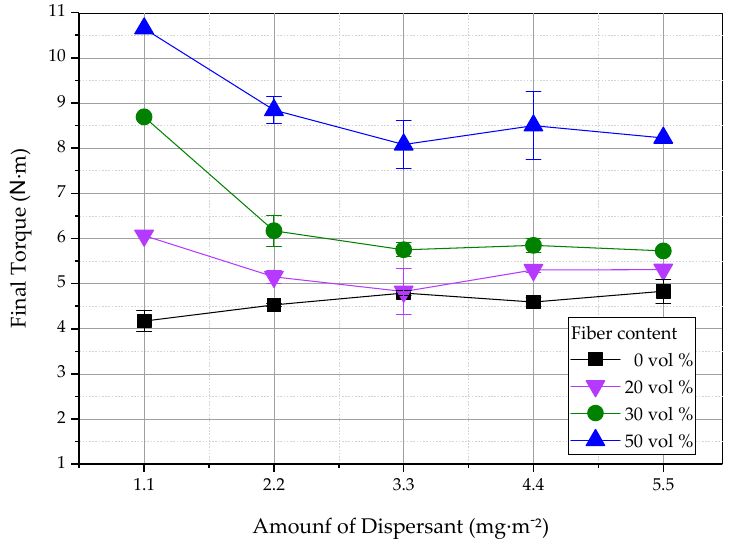
Figure 5. Effect of increasing stearic acid on various paraffin wax-based feedstocks with increasing fiber content.